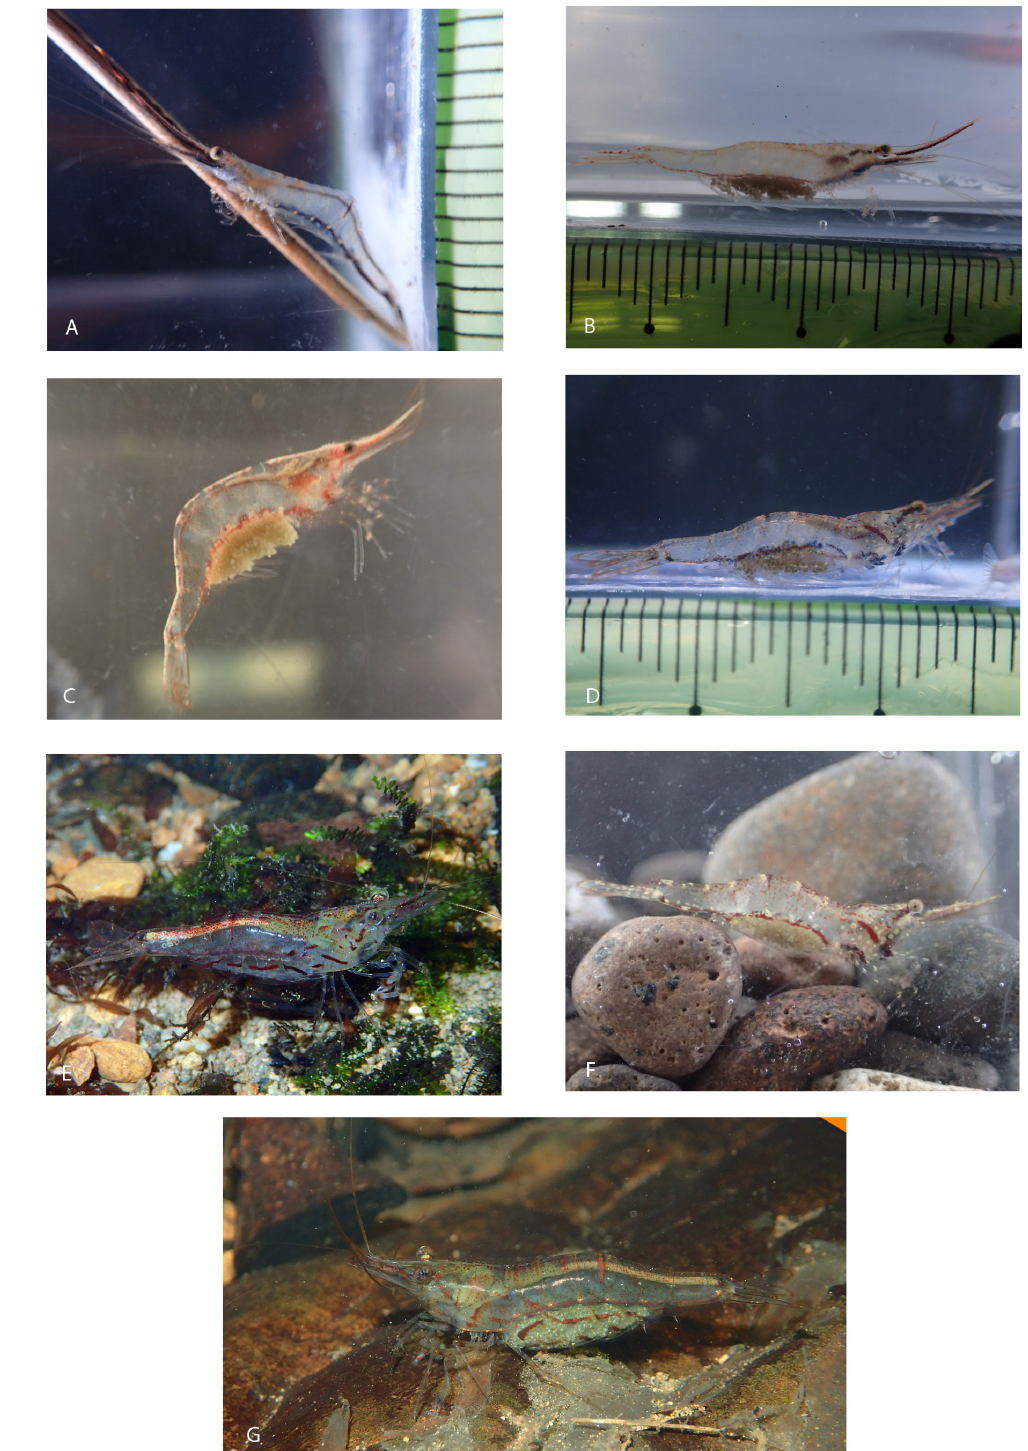
Fig. 25. Live colourations. A . Caridina gracilirostris De Man, 1892 (MNHN-IU-2018-2804). B . Caridina neglecta Cai & Ng, 2007 (MNHN-IU-2018-2811). C . Caridina appendiculata Jalihal & Shenoy, 1998 (MNHN-IU-2018-135). D . Caridina brevidactyla Roux, 1919 (CA1503). E . Caridina choiseul sp. nov. (Choiseul Island). F . Caridina intermedia sp. nov. (MNHN-IU-2014-20847). G . Caridina mertoni Roux, 1911 (Kolombangara Island). Photographs by P. Keith